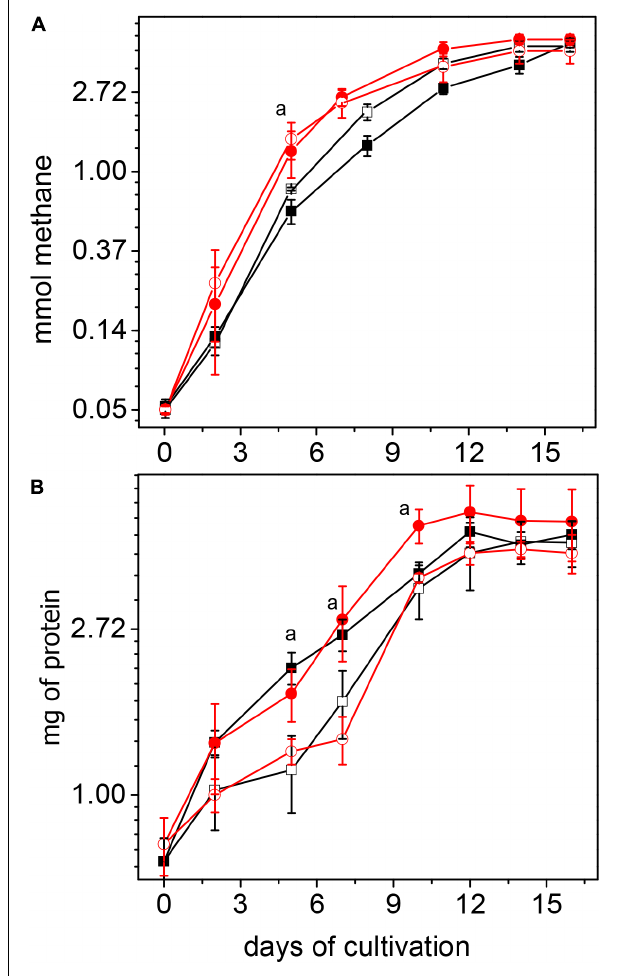
FIGURE 1 | Growth of Methanosarcina acetivorans cultured with acetate. Methane production (A) and protein synthesis (B) were determined in control cell cultures ( (cid:3) ); control cells exposed for first time to Cd 2 + ( (cid:4) ); cultures with CdPA cells ( • ) and CdPA cells cultures where Cd 2 + was omitted for first time ( ◦ ). Rates of methane production determined by considering the linear part of the plot (up to day 5) in mmole x day − 1 were: Cnt cells: 0.15 ± 0.03; Cnt + Cd: 0.13 ± 0.02; CdPA: 0.25 ± 0.05 and CdPA-Cd: 0.29 ± 0.06. Values shown are the mean ± SD of 3 independent experiments. a P < 0.05 in methane synthesis at day 5 between CdPA vs. Cnt and Cnt + Cd; as well as in protein content at day 5 and 7 between CdPA vs. Cnt and CdPA-Cd and at day 10 vs. cnt, cnt + Cd and CdPA-Cd.